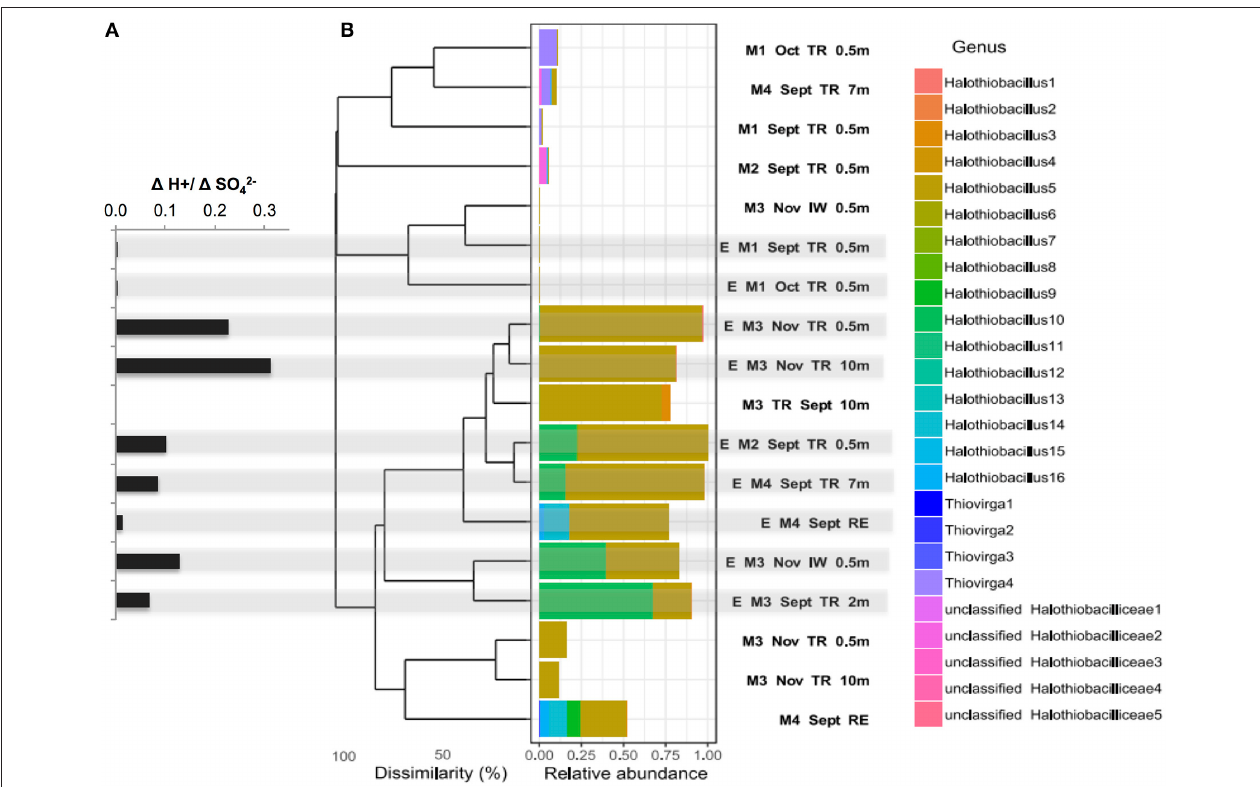
FIGURE 3 | (A) Net acid generation relative to net sulfate generated ([H + :[SO 2 − 4 ]) (bold stars) for each SoxBac enrichment and (B) Bray-Curtis dissimilarity based hierarchical clustering of samples for all the single absolute sequences clustered at genus level for the family Halothiobacillaceae. Sequences were obtained by Illumina sequencing of 16S rRNA gene amplicons for the different mines, mining environments and its enrichments. Halothiobacillaceae relative abundance is calculated per sample and relative to the whole microbial community. Gray shading indicates the 1 H + : 1 SO 2 4 - ratios that correspond to each enrichment SoxBac